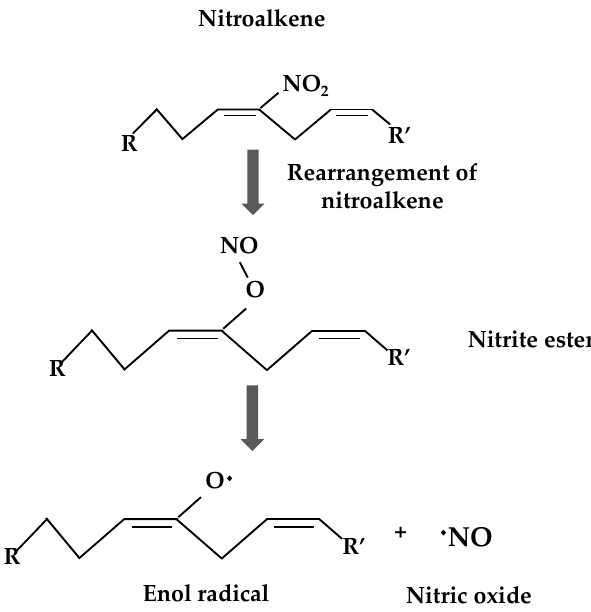
Figure 3. Release of nitric oxide from nitroalkenes through a rearrangement process. A nitrite ester is formed and homolyzed to yield NO and an enol radical (modified from Reference